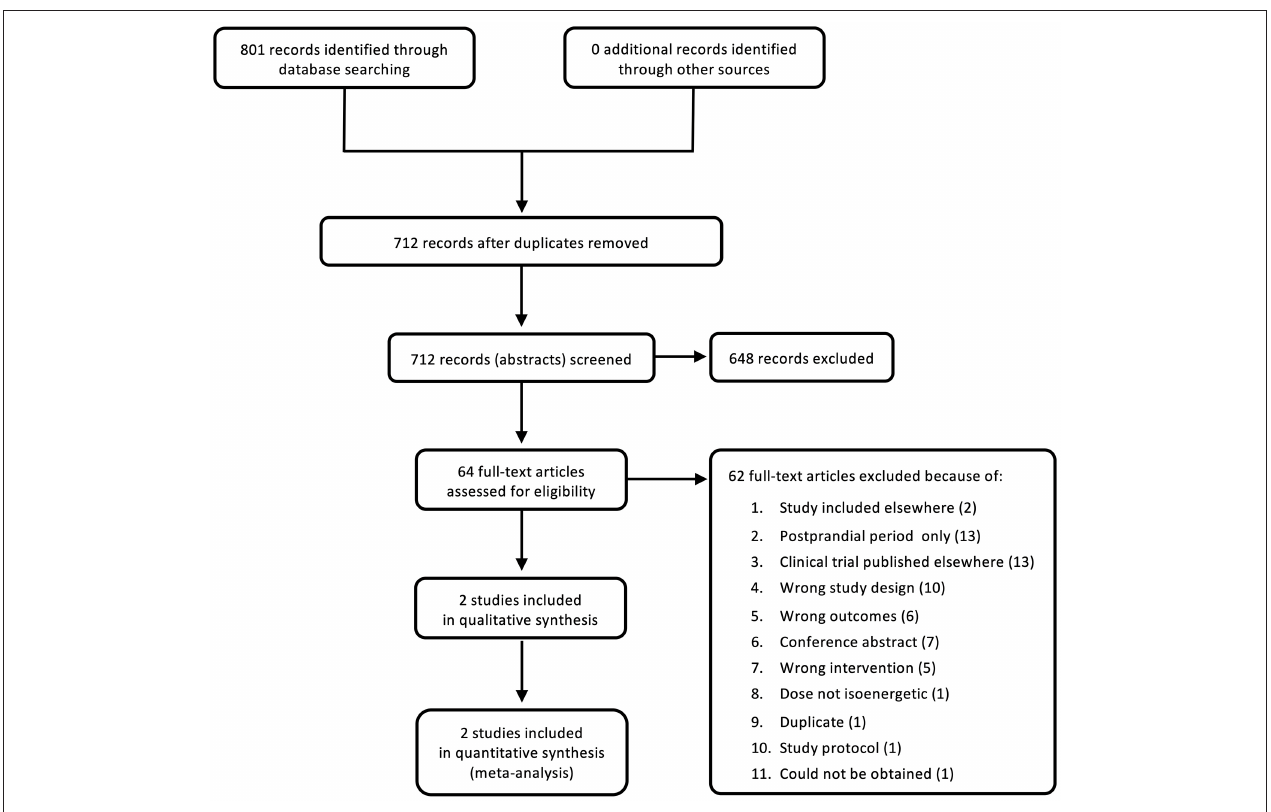
FIGURE 1 | PRISMA flow diagram of searches and study